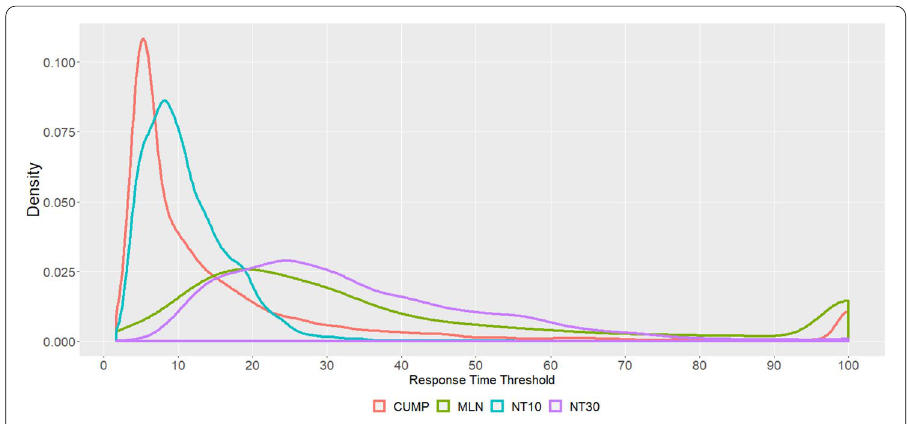
Fig. 2 Comparison of response time thresholds across four